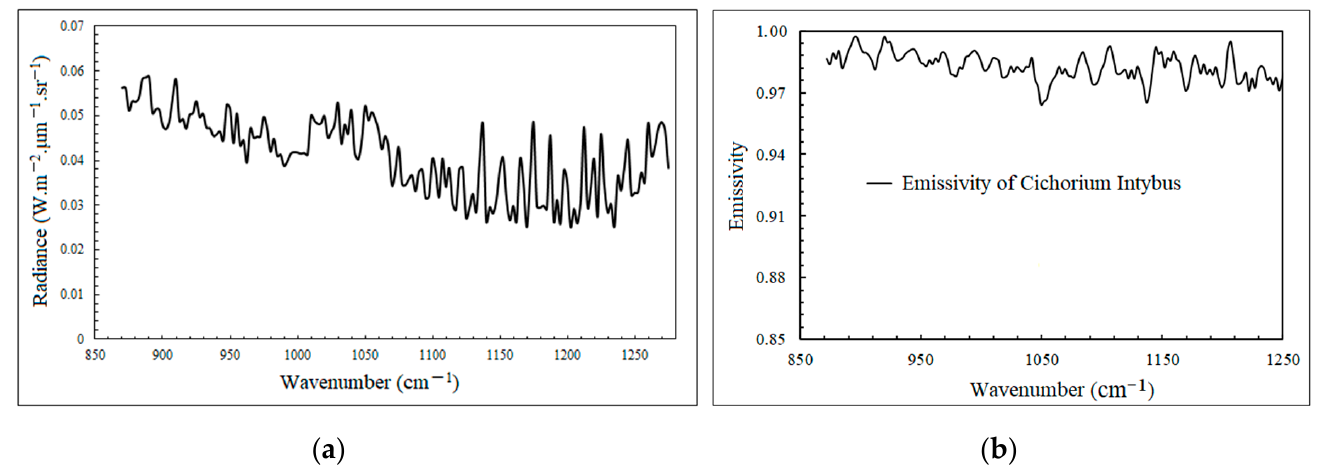
Figure 19. Temperature of Cichorium intybus.